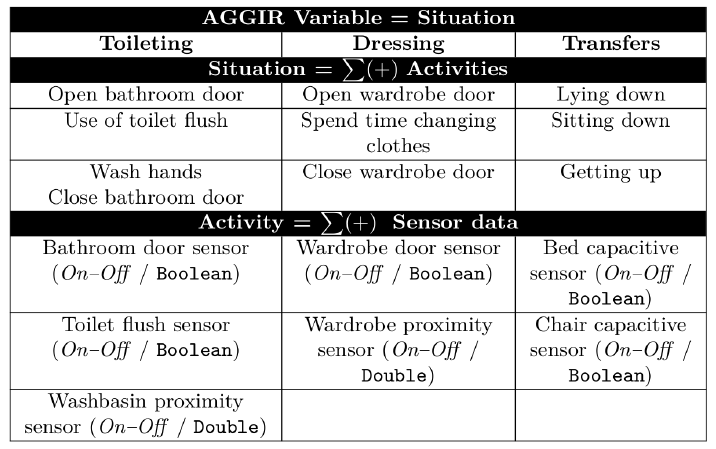
Figure 10. Orchestration of activities/AGGIR Variables.